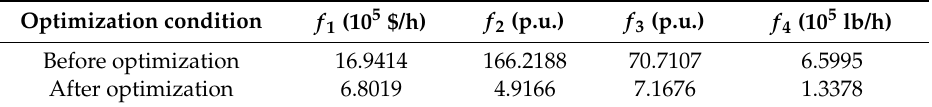
Table 8. Comparison results before and after